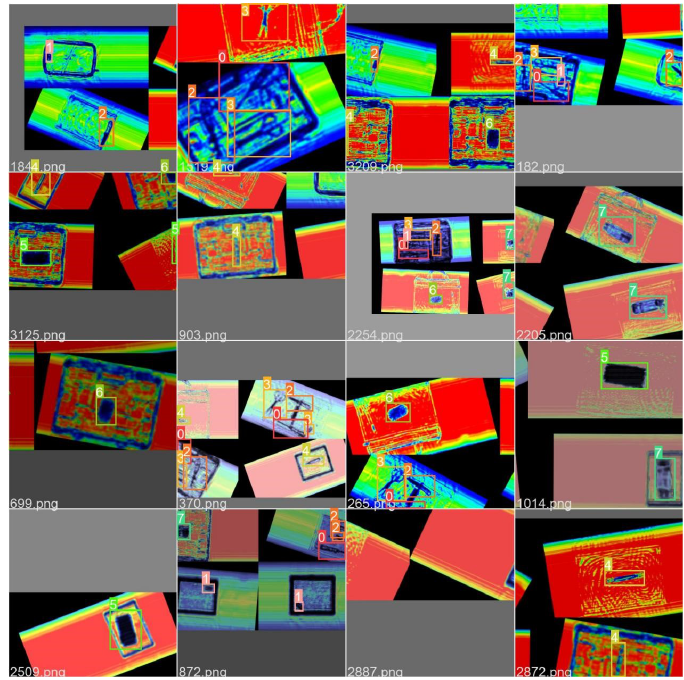
Figure 14. Mosaic augmentation for training